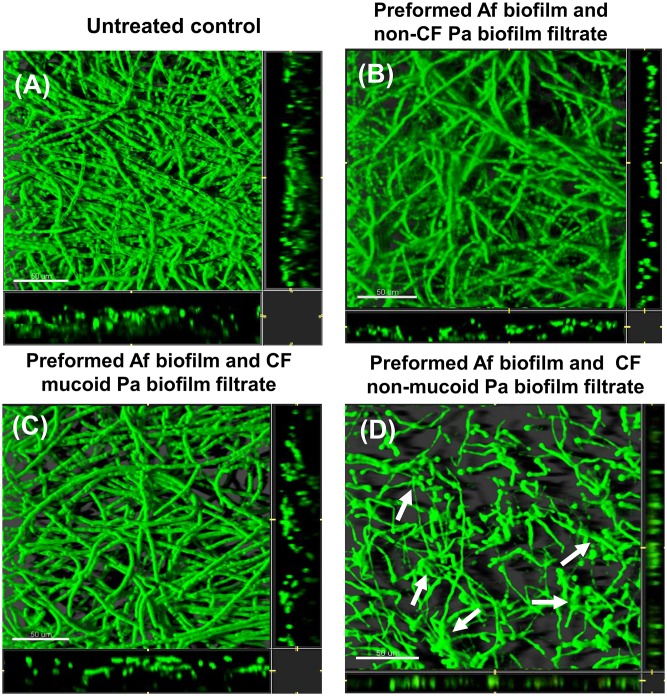
CLSM images of Af biofilm after challenging preformed Af biofilm for 24 h with Pa biofilm spent supernatant.Horizontal (xy) view of reconstructed 3-dimensional images of FUN1-stained biofilms, with filter set to capture green fluorescence. Thickness of the biofilm can be observed in the side view of the reconstruction (extreme right and lower panels in each picture). (A) Untreated control. (B) Af preformed biofilm exposed to spent supernatant of a non-CF Pa biofilm spent supernatant for 16 h or (C) exposed to mucoid CF Pa biofilm spent supernatant or (D) exposed to non-mucoid CF Pa biofilm spent supernatant. Arrows show the amorphous structures distributed throughout the intertwined altered filamentous networks in treated cultures. Magnification, ×63. Bar, 50 μm.